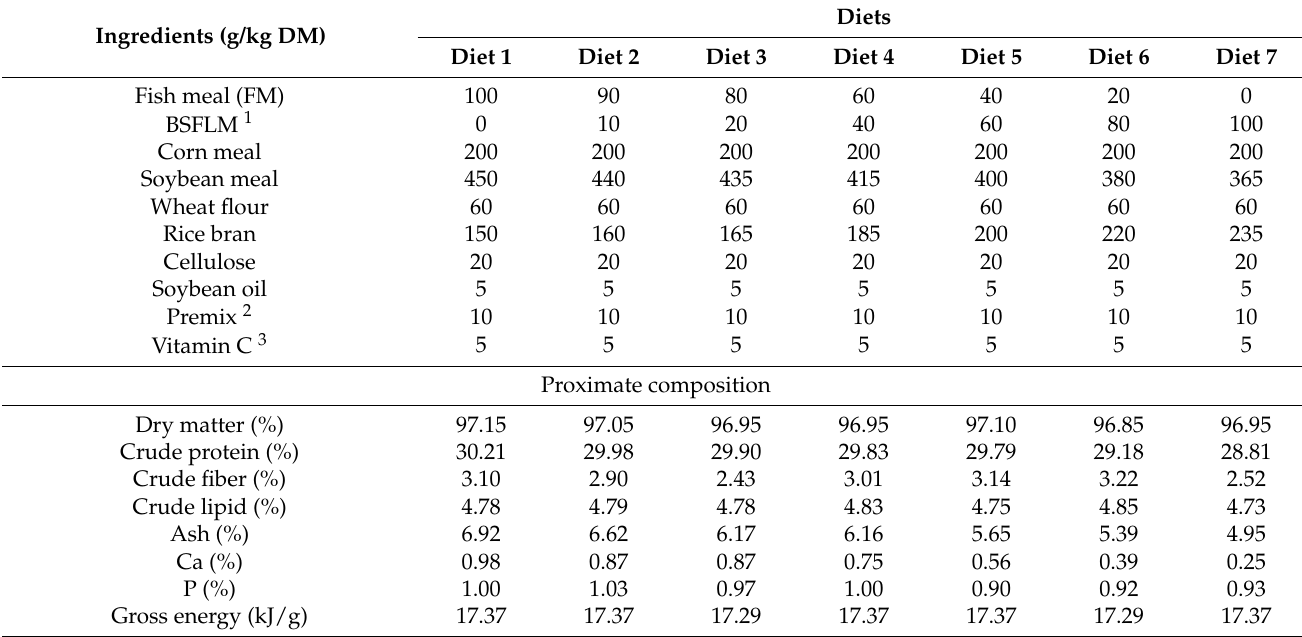
Table 1. Ingredients and proximate composition of the experimental diets.